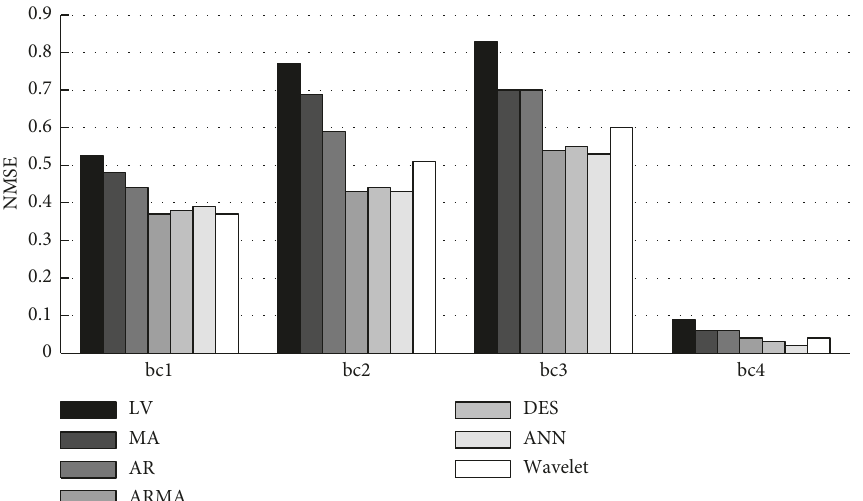
Figure 8: Normalized mean square error for BC traces.